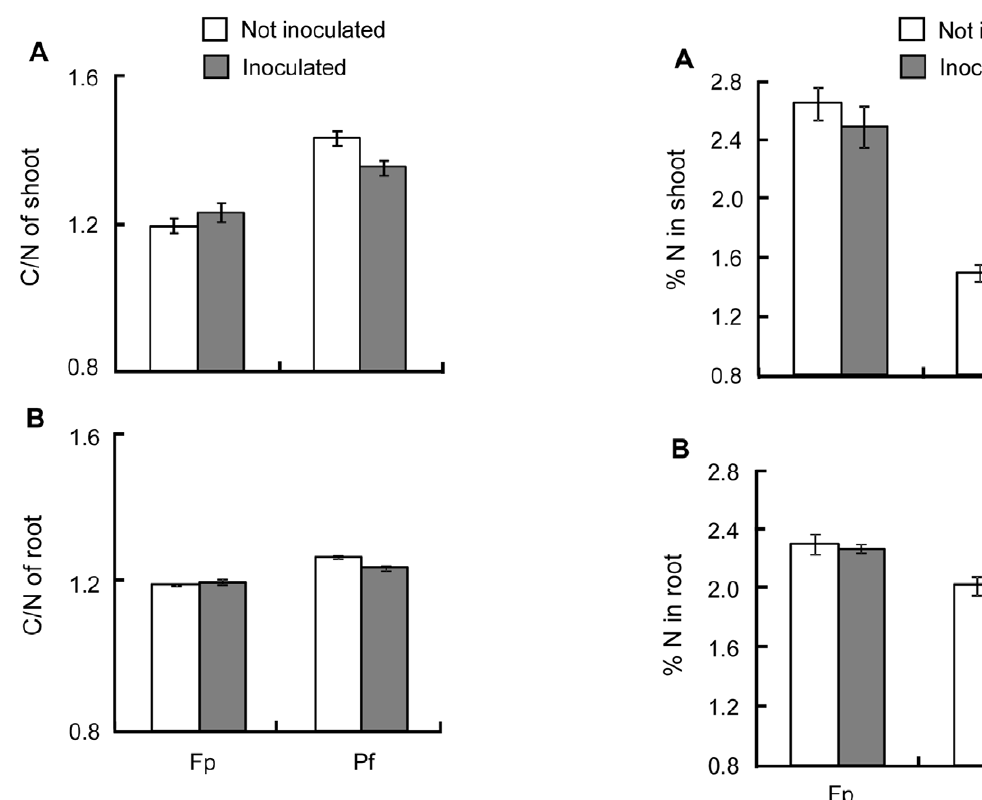
Figure 2. Average C/N ratio for shoot and root of Medicago truncatula . Average C/N ratio for the shoot (A) and the root (B) depends on the developmental stage (Fp, Pf, see text) and the condition of inoculation (Inoculated or not with Pseudomonas fluorescens C7R12). Data were log-transformed to achieve normality and equal variances respectively tested by Shapiro-Wilk and Bartlett tests. Carbon-Nitrogen ratio, measured during the second experiment replicate only, was analysed by linear model with condition of inoculation, CO 2 concentration and developmental stage as fixed factors and with their interactions. Standard errors are represented by vertical bars.